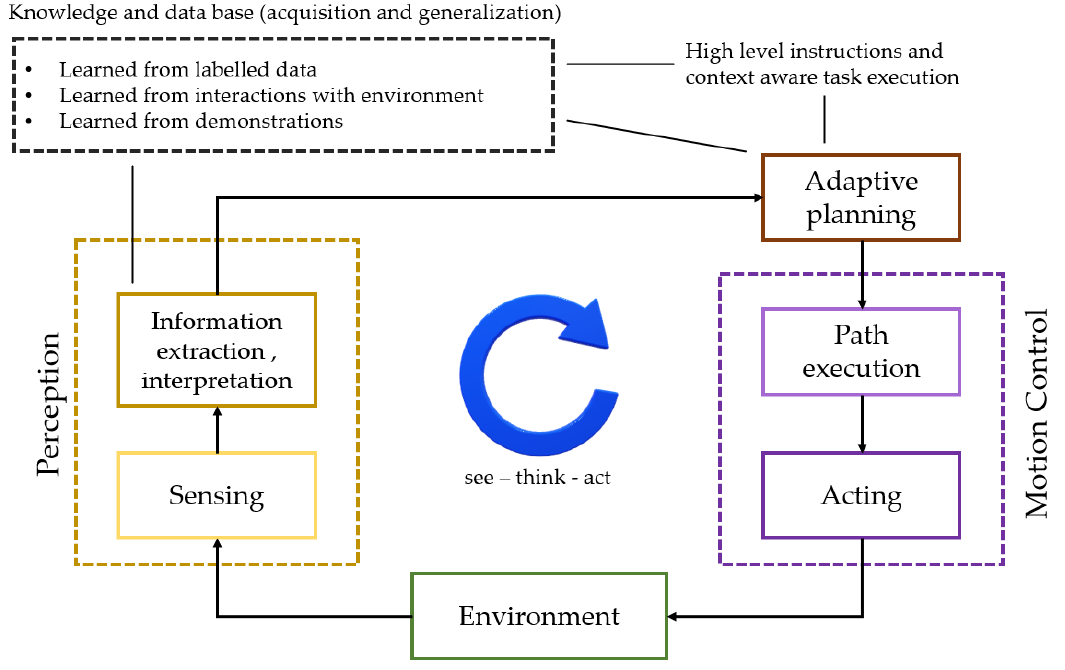
Figure 1. Smart industrial robot